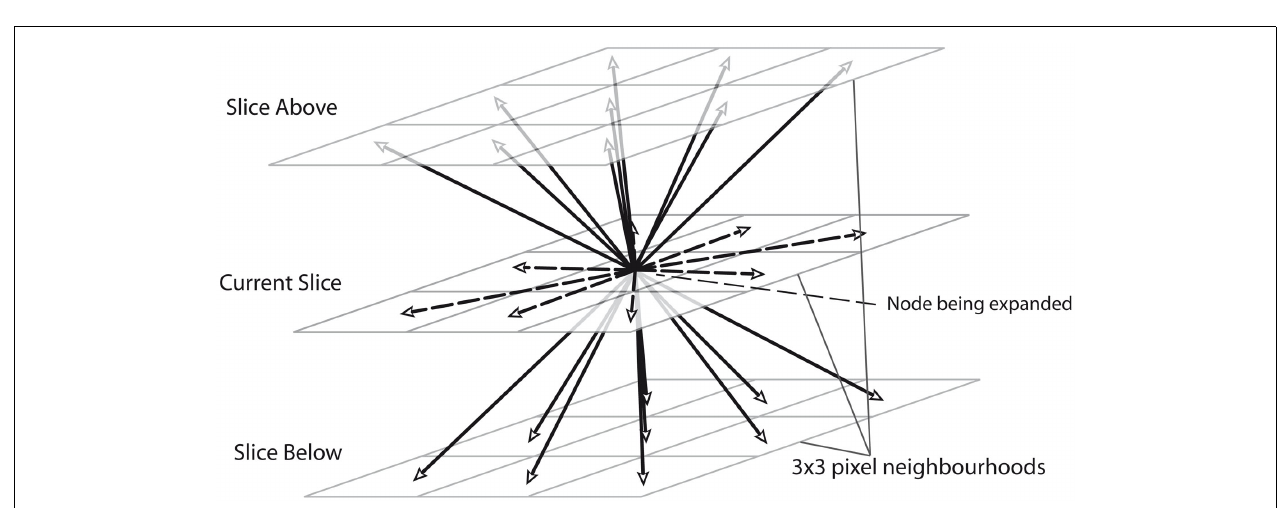
FIGURE 2 | Example of ρ (x) response from the steerable filters for varying values of σ . From left-to-right: the original image, the ρ ( x ) response with an appropriate value of σ , the response with an